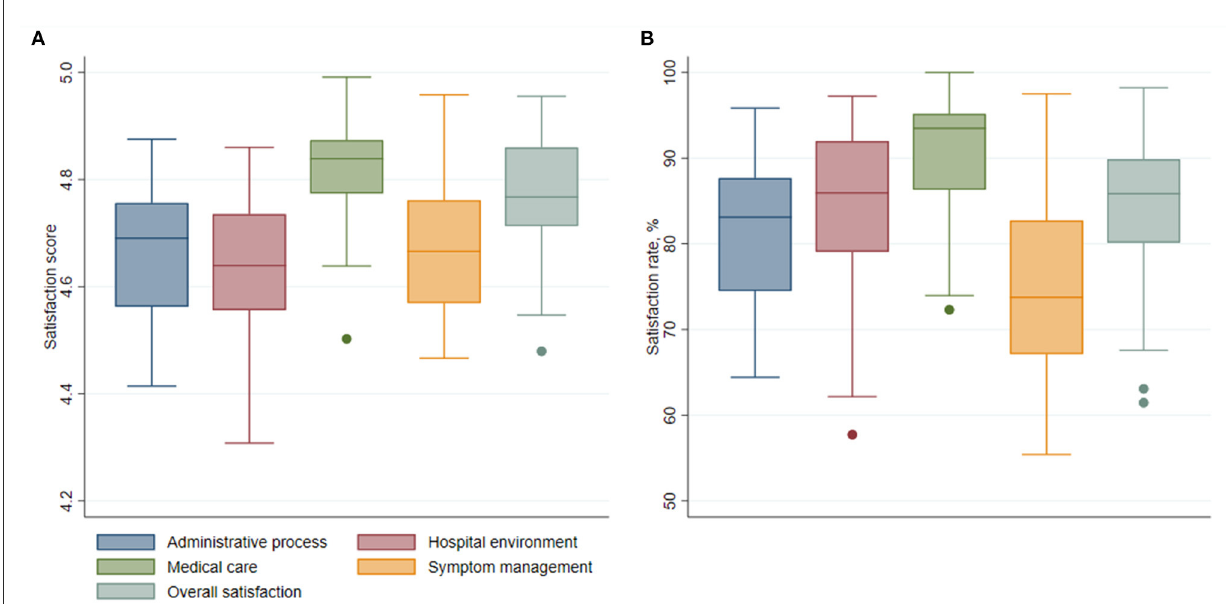
FIGURE1 Patient satisfaction aggregated at hospital level over five aspects. (A) Box plot of patient satisfaction scores over five aspects. (B) Box plot of patient satisfaction rates over five aspects.